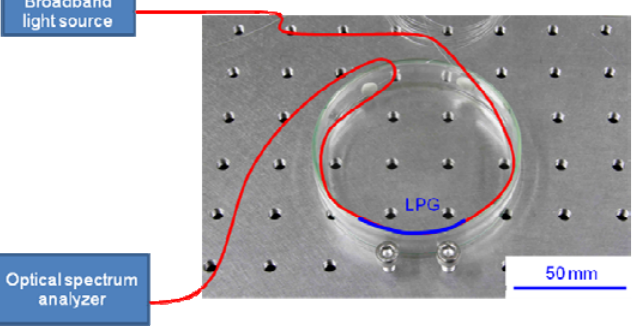
Figure 6. Experimental setup for measuring the transmission spectrum of a bent LPG.